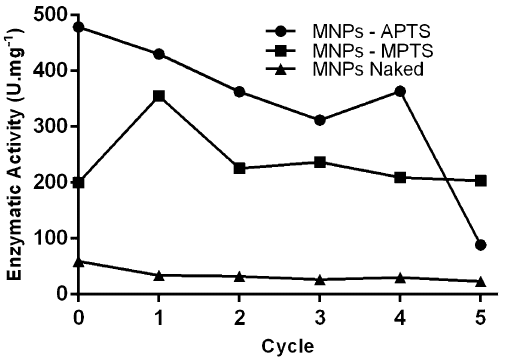
Figure 8. Residual enzymatic activity after five cycles of reuse of immobilized